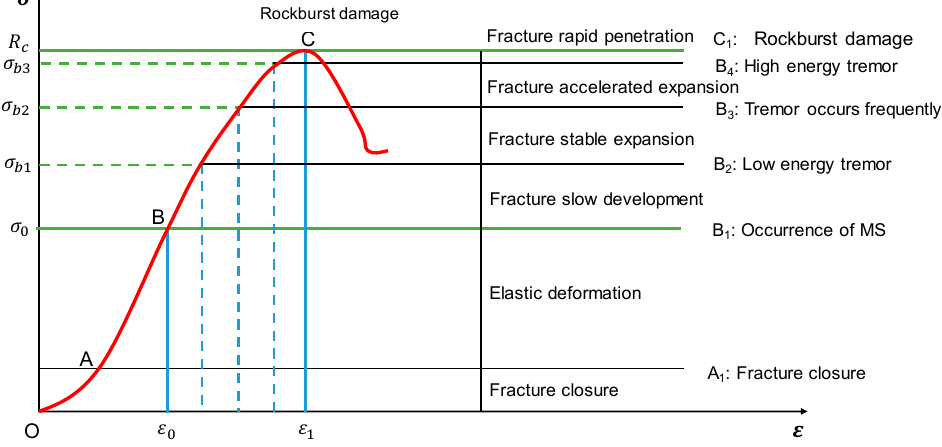
Figure 1. Stress-strain curve of coal-rock specimens during the deformation-failure process (Dou et al. 2017).